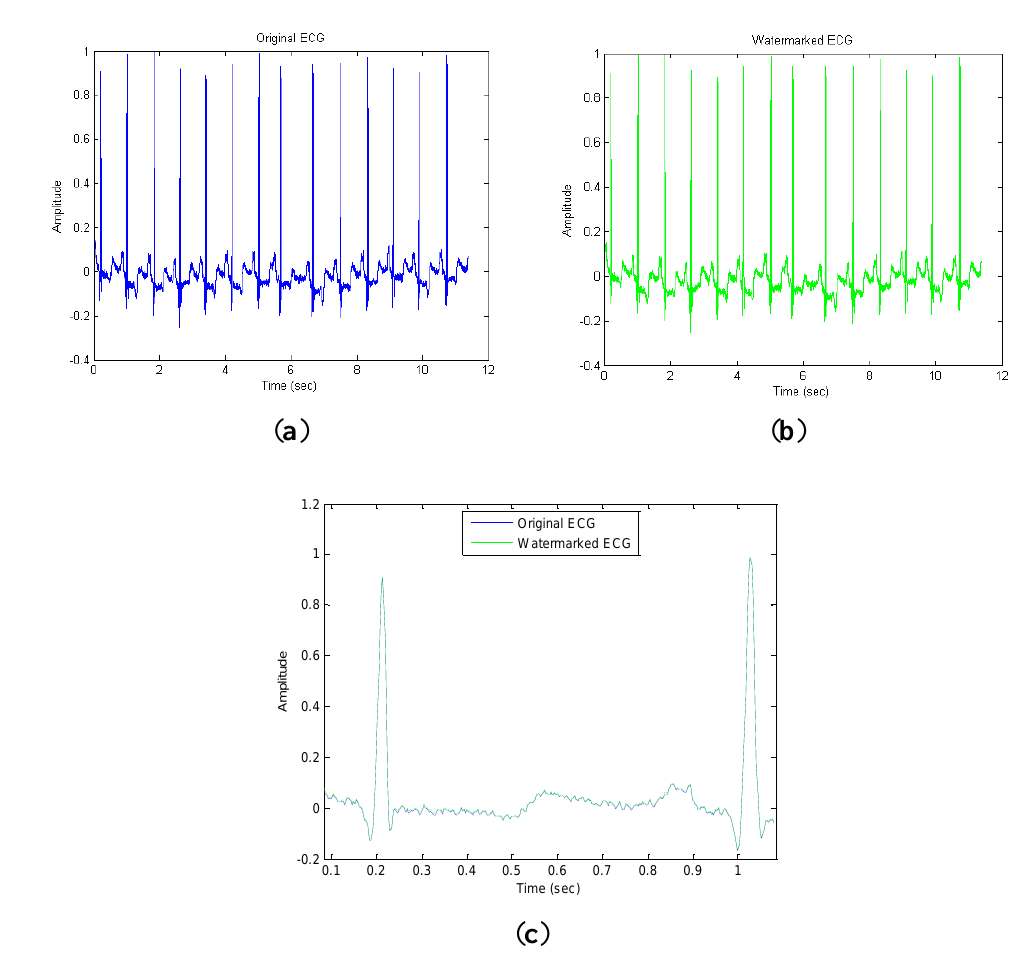
Figure 6. The original and watermarked ECG. ( a ) Watermarked signal ( b ) Original signal; ( c ) Waveform comparison between 0.09 and 1.09